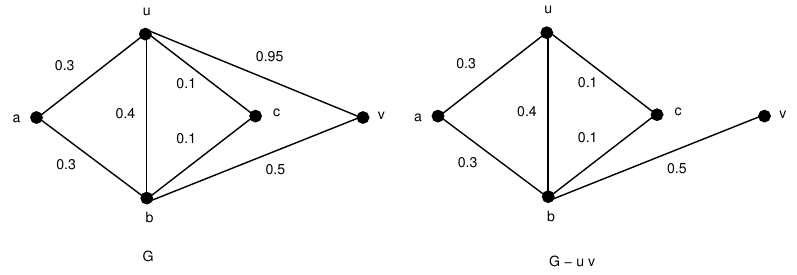
Figure 3. Fuzzy graphs G and G − uv